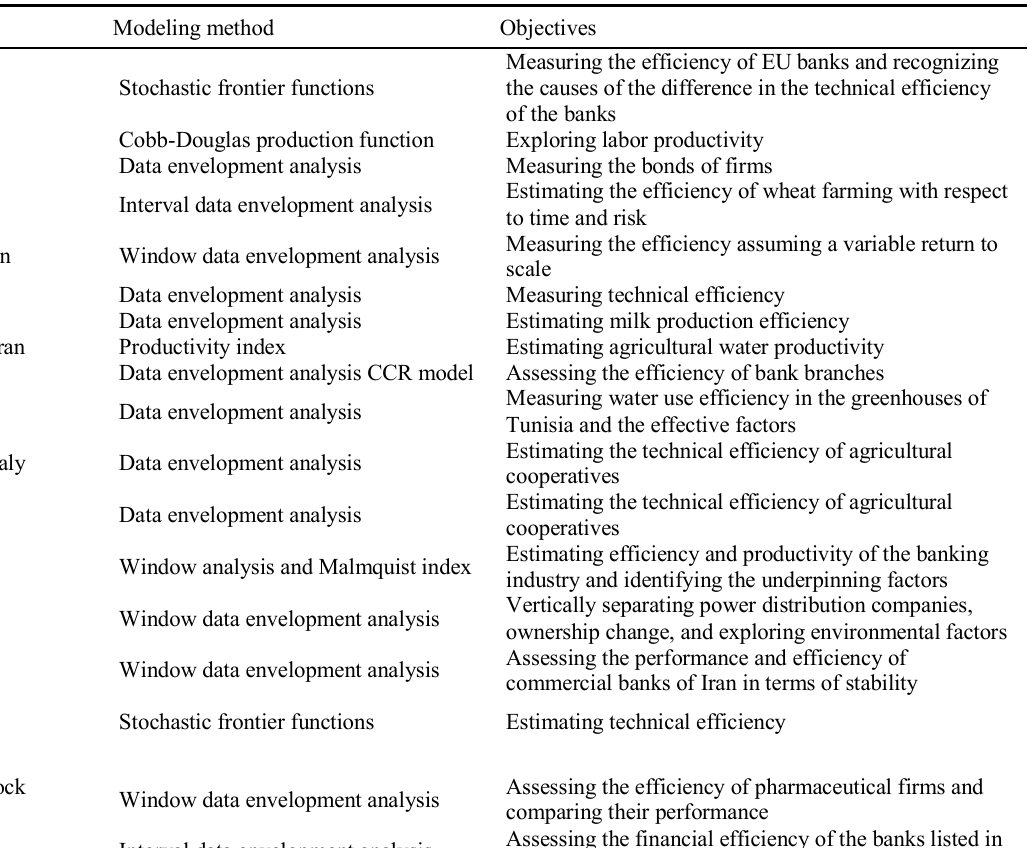
Table 1. A list of other relevant